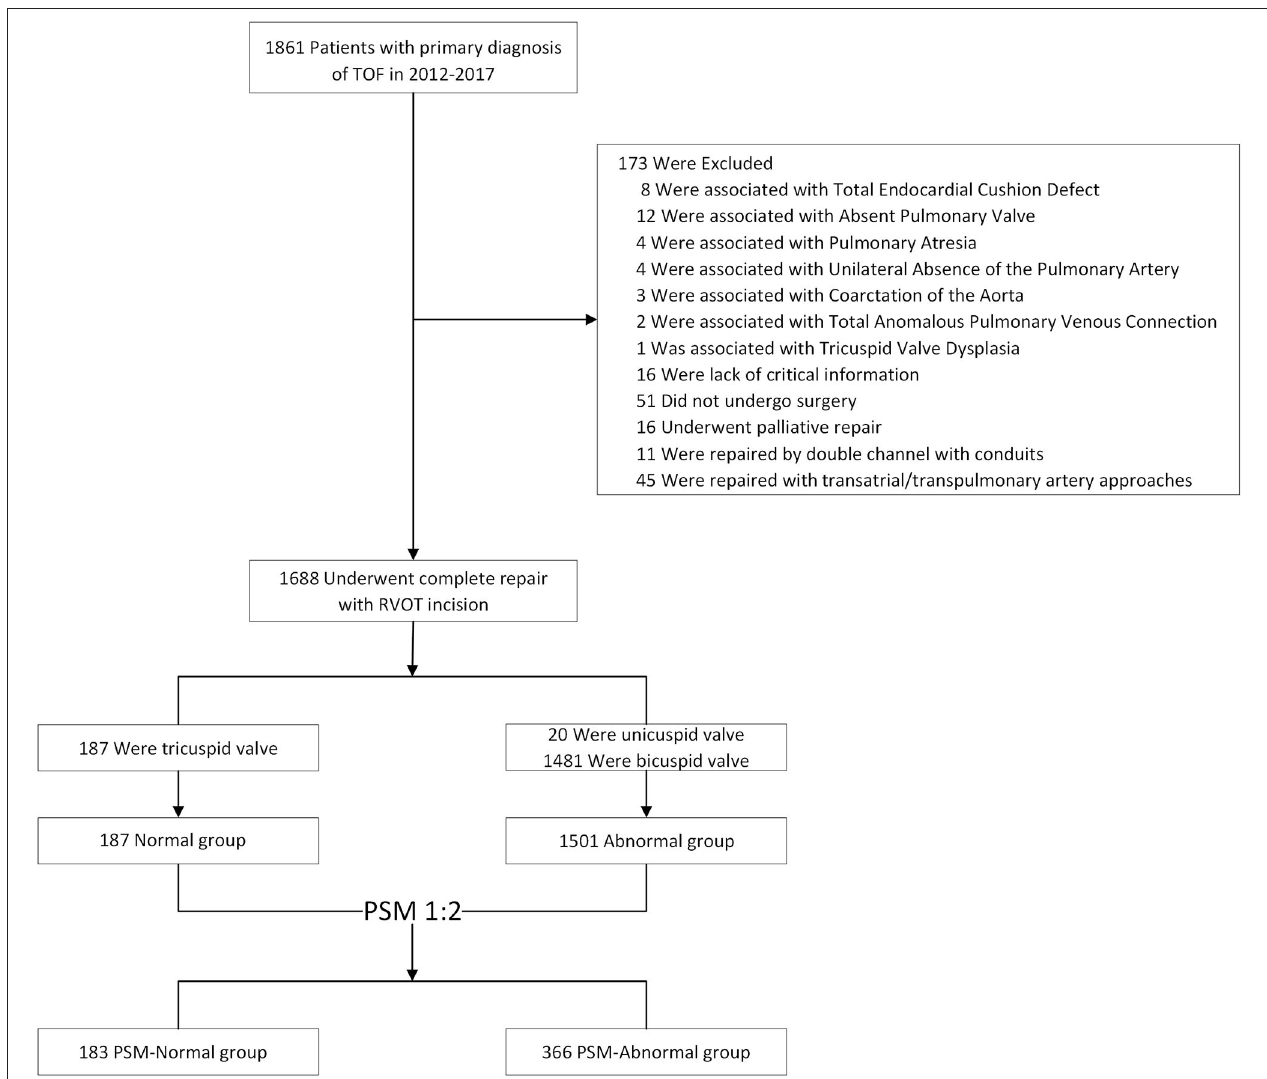
FIGURE 1 | Cohort assembly. Final cohort derivation for pulmonary valve morphology differences after the application of study eligibility